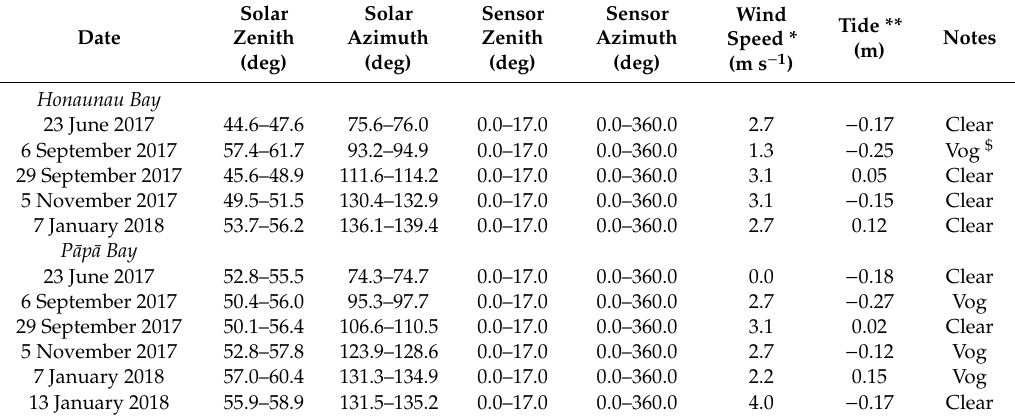
Table 1. Repeat Global Airborne Observatory data acquisitions over Honaunau and P¯ap¯a Bays including dates, illumination and viewing geometries, and sea surface